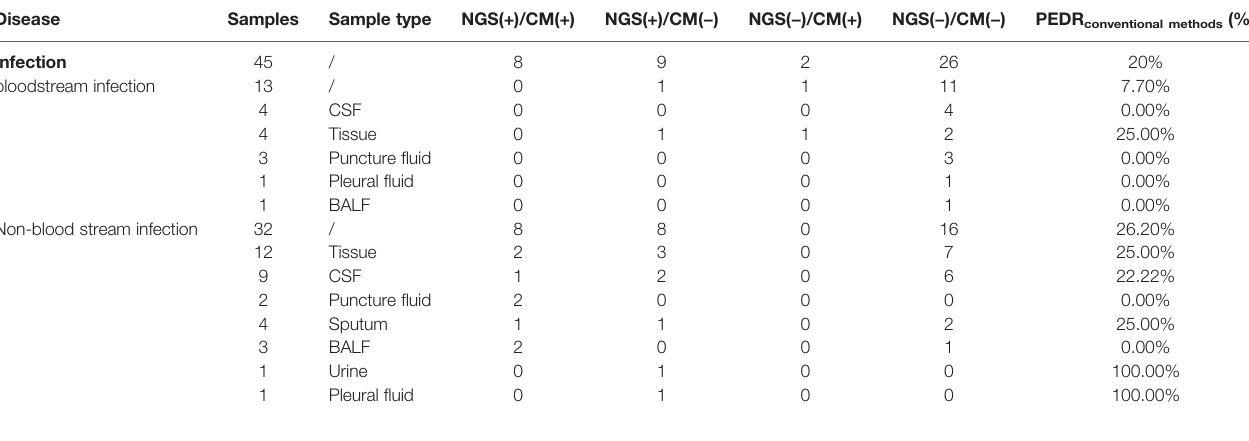
TABLE 5 | The diagnostic value of mNGS compared to conventional methods in non-blood samples in FUO.